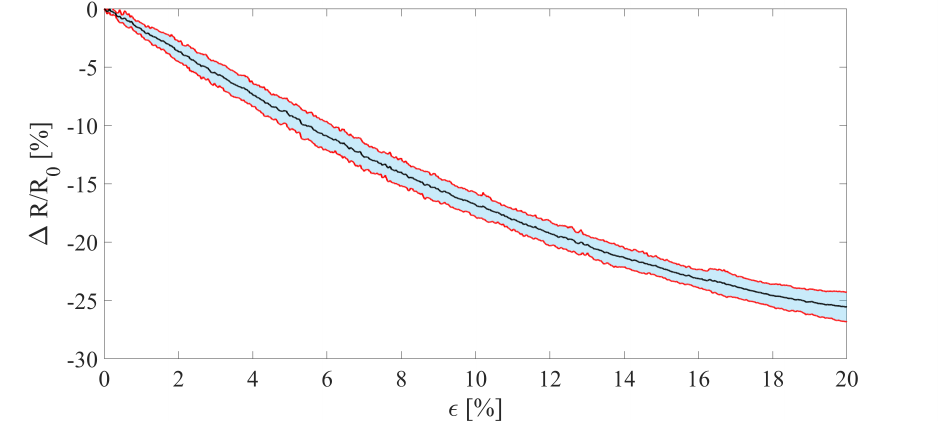
Figure 5. Relative resistance change of the stem growth sensor when strain up to 20%. The black line represents the average output curve, the red lines delimit the blue shaded area which represent the expanded